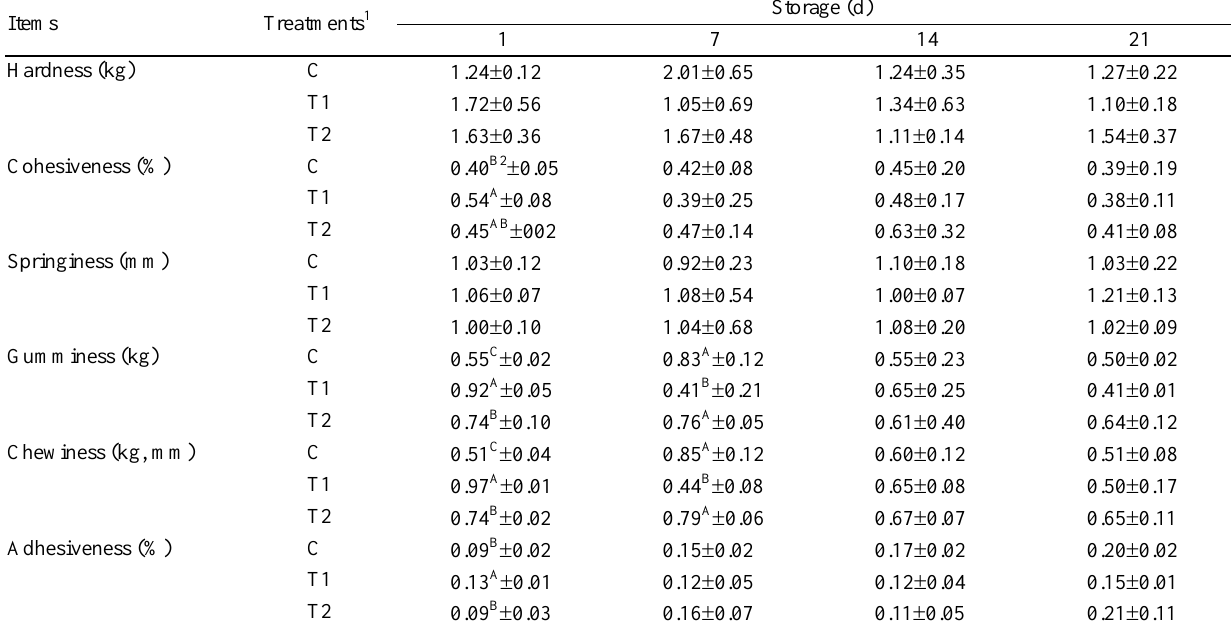
Means  SD with different superscripts in the same differ column significantly at